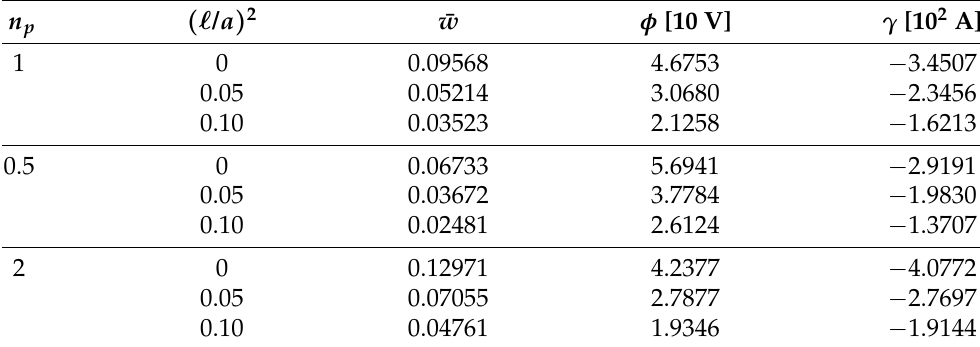
Table 9. Displacement ¯ w , electric and magnetic potential φ and γ , of a square nanoplate in central point ( a /2, b /2 ) for different values of nonlocal parameter ( (cid:96) / a ) 2 and n p . (UDL; q = 0 N/m 2